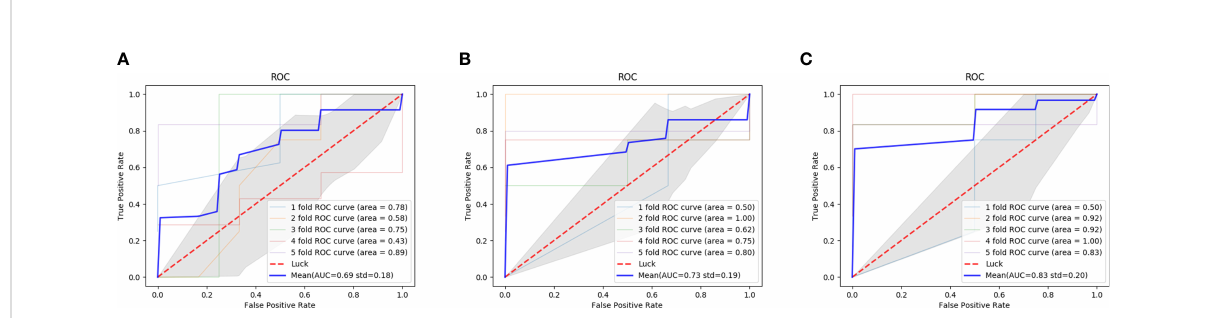
FIGURE 5 ROC curves of the performance of different diagnostic branch models in the 5-fold cross test. (A) the AUC of the CT branch; (B) the AUC of the MRI branch; (C) the AUC of the MIX branch; ROC, receiver operating characteristic curve; AUC, the area under the receiver operating characteristic